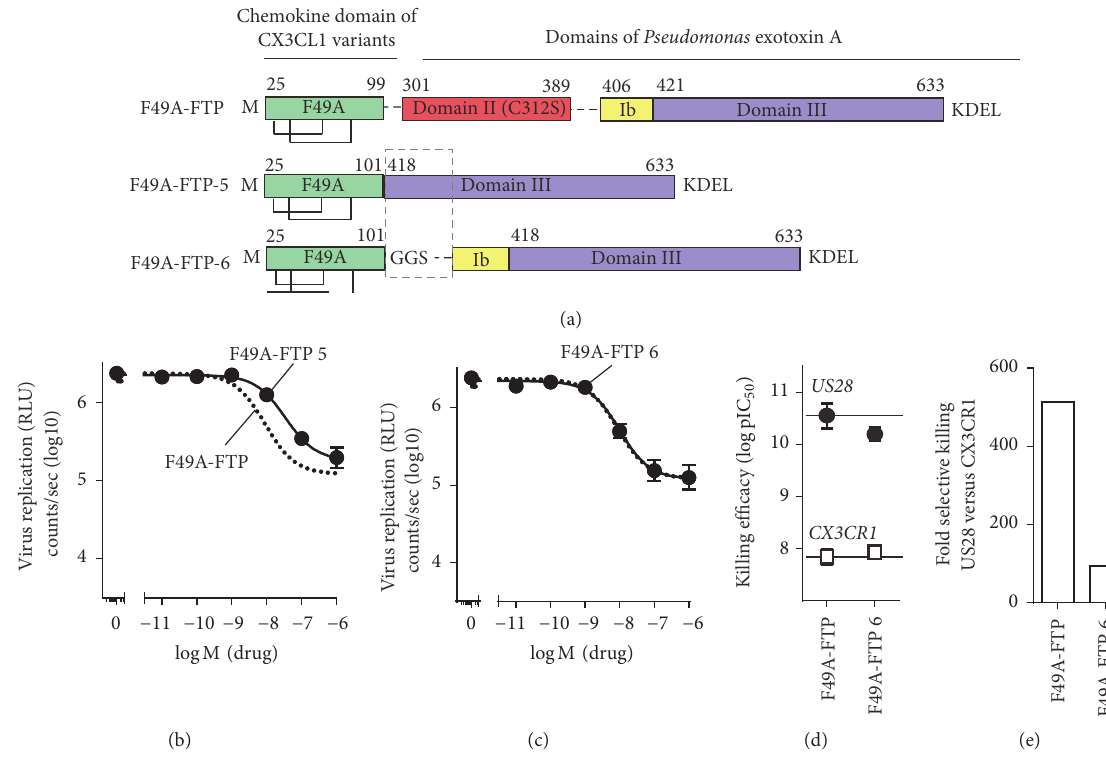
Figure 4: Design, cell killing, and antiviral activity of FTPs without domain II and optional with as GS-linker and Ib domain. (a) F49A-FTP as template for F49A-FTP-5 without domain II between the chemokine domain of CX 3 CL1 and domain III of PE or for F49A-FTP-6 with an additional amino-acid linker (GGS) and part of the Ib domain. (b-c) Inhibition of virus replication measured by luciferase activity of MRC-5 cells infected with Toledo LUC (MOI 0,1) and treated once with F49A-FTP (pos. control; dotted line), F49A-FTP-5, and F49A-FTP-6 (black circles). (d-e) Selectivity of F49A-FTP and F49A-FTP-6 determined as fold improved potency in killing US28- relative to CX 3 CR1-expressing cells. Error bars indicate SEM for 3–5 independent biological